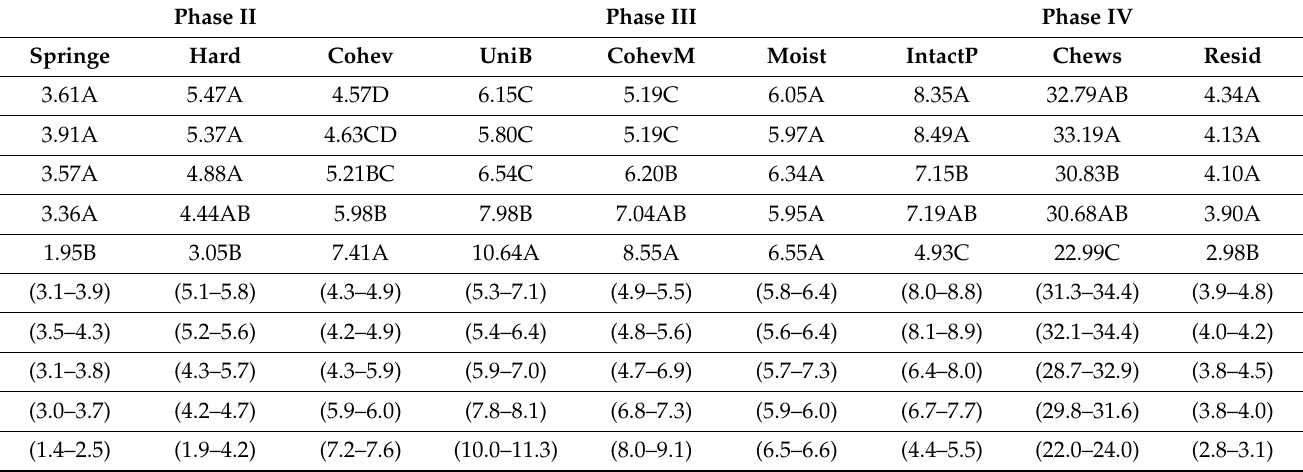
Table 6. Cooked rice texture attributes of 3 high amylose haplotypes, Wells and Hidalgo † .